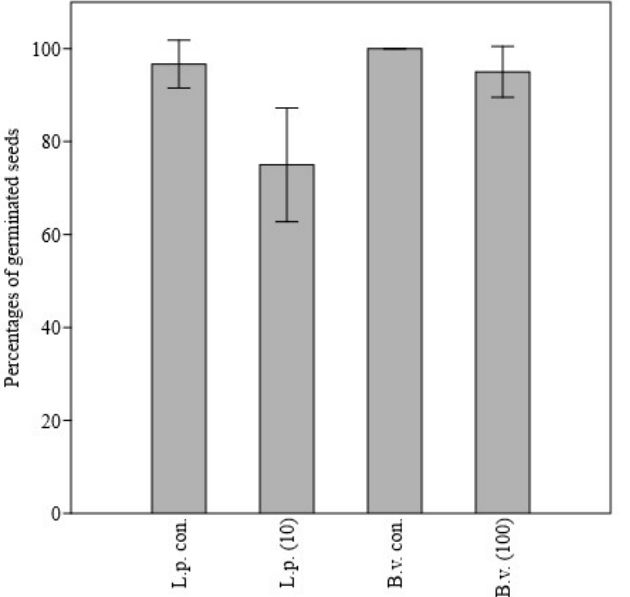
Figure 2. Bar-chart showing differences between Lolium perenne (L.p.) and Barbarea vulgaris (B.v.) percentages of germinated seeds in comparison to control (con.) after application of 10 µg/mL and 100 µg/mL of Juniperus horizontalis essential oil.